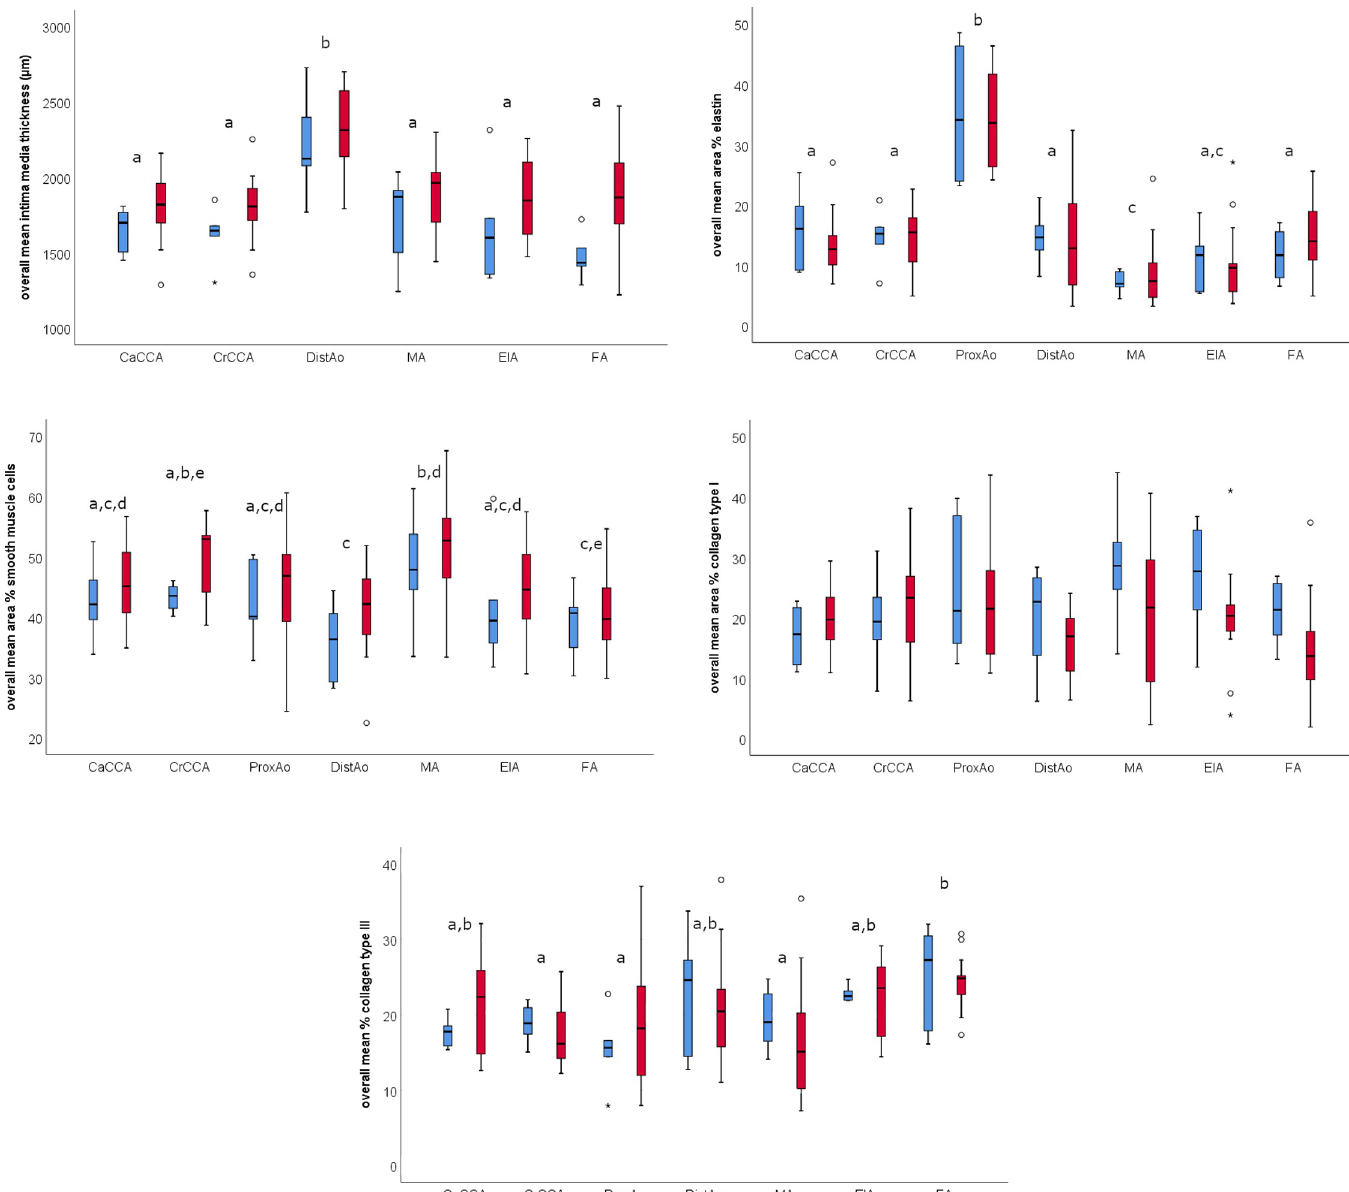
Fig 5. Overview of the overall mean intima media thickness, area % of elastin, area % of smooth muscle cells, area % of collagen type I and area % of collagen type III in young (blue) and old (red) horses, grouped by location. For each variable, the median and spread is indicated by a boxplot with the line in the box marking the median value, the box span indicating half of the observations and the whiskers indicating the range. Outliers (open circles) and extreme outliers (asterisks) are plotted individually at the end of the whiskers. A significant effect of age was found for the overall mean intima media thickness (p = 0.001) and the overall area % of smooth muscle actin (p = 0.027), independent from arterial location. Different characters above the boxplots indicate a significant difference between locations, independent of age. CaCCA: caudal common carotid artery; CrCCA: cranial common carotid artery; ProxAo: proximal aorta; DistAo: distal aorta; MA: median artery; EIA: external iliac artery; FA: femoral